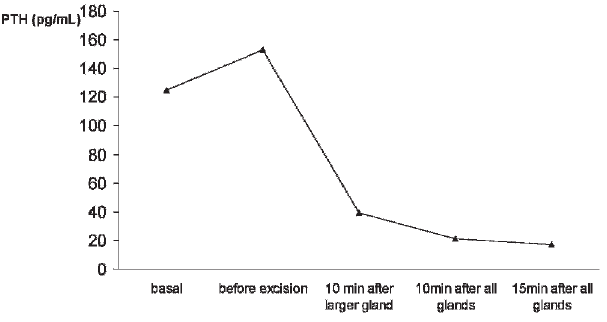
Figure 5 - A marked decrease of intra-operative parathyroid hormone (ioPTH) after excision of the largest parathyroid